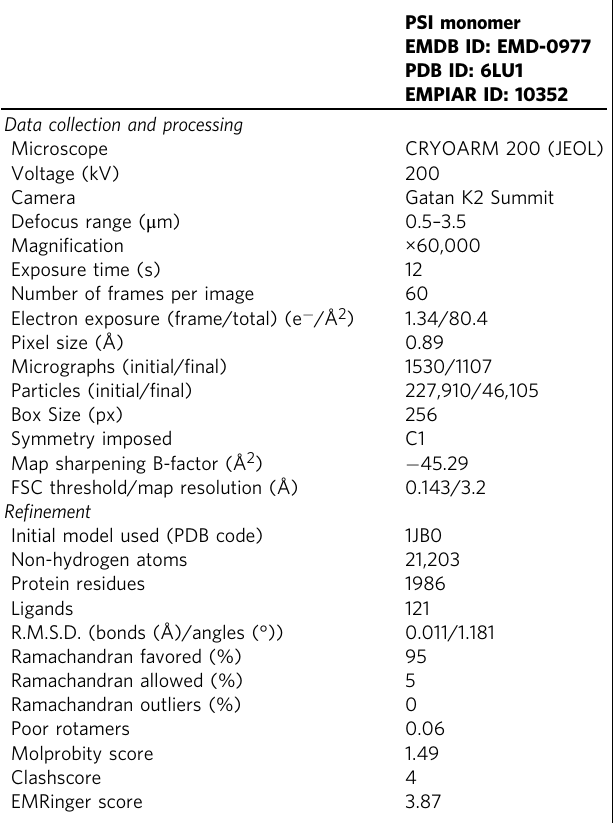
Table 3 X-ray data collection and re fi nement